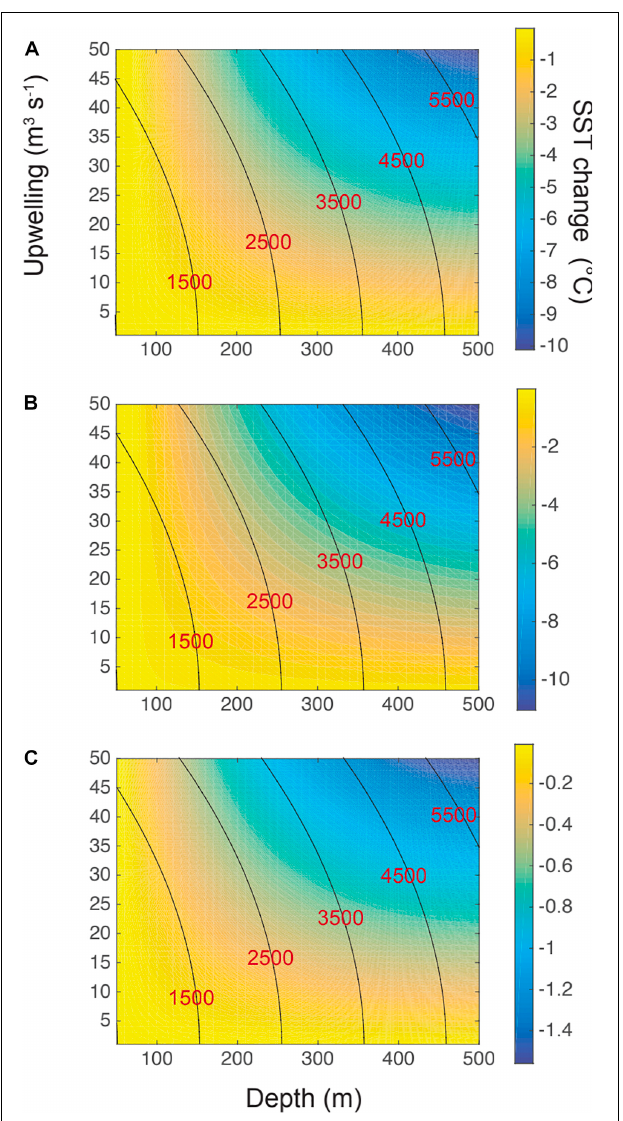
FIGURE 5 | The quantitative analysis for required AU input by investigating the surface cooling effects after the first-year’s AU implementation. Area-mean SST differences between AU runs and control run are plotted against AU upwelling rate and AU depth for regions GBR (A) , SCS (B) , and HWI (C) . To pump 1 m 3 bottom water to sea surface adiabatically, required energy (unit: kJ) is plotted as isoclines over the SST